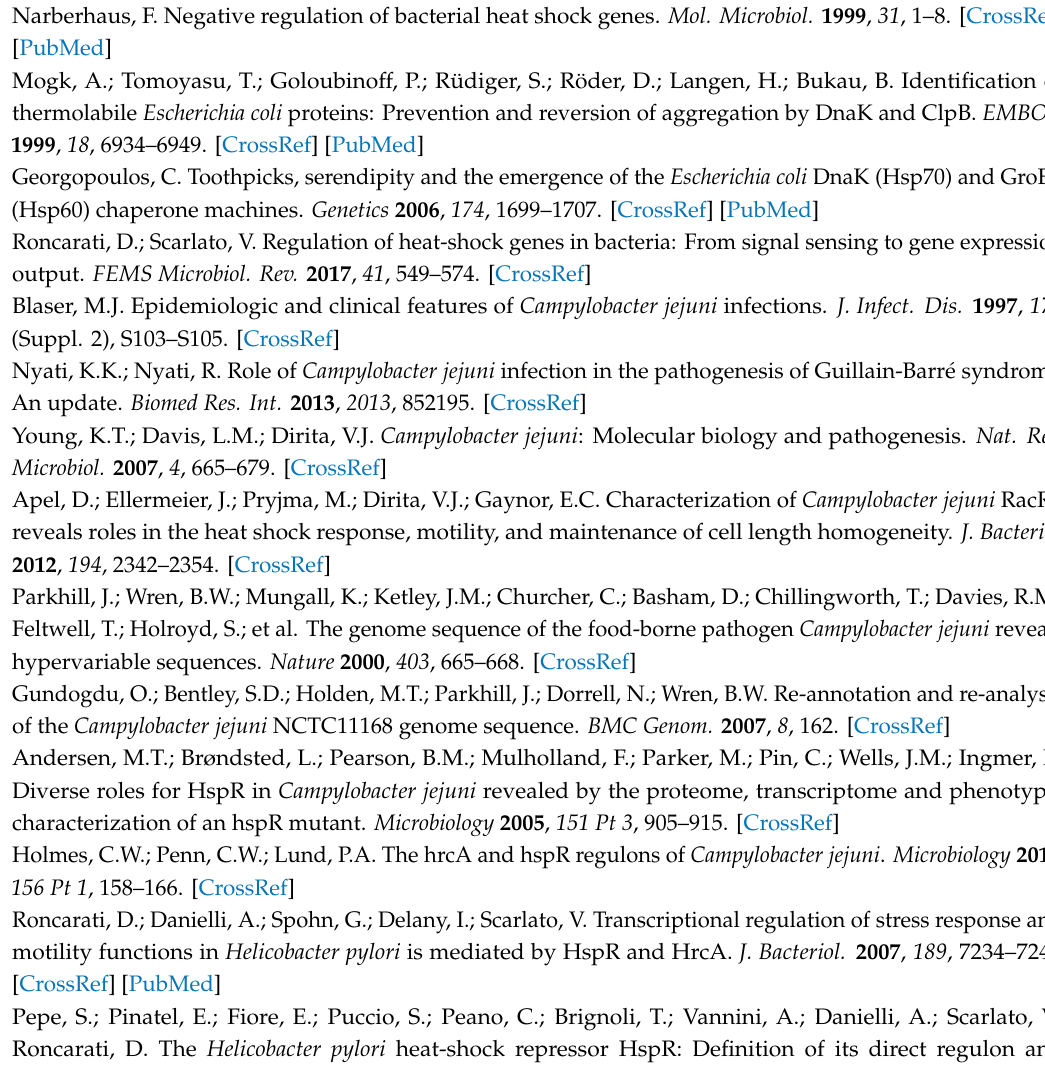
Figure S1: DNase I footprinting assays of HspR on wild type and mutant P cbp probes, Figure S2: In vitro crosslinking assay of HrcA and HspR proteins with formaldehyde, Figure S3: Bacterial Adenylate Cyclase Two-Hybrid System (BACTH) assays, Figure S4: Schematic representation of wild type and three di ff erent P gro mutant probes used in footprinting experiments reported in Figure 3, Figure S5: Schematic representation of wild type and three di ff erent P gro mutant probes used in footprinting experiments reported in Figure 4, Table S1: List of oligonucleotides used in this study, Table S2: List of plasmids used in this